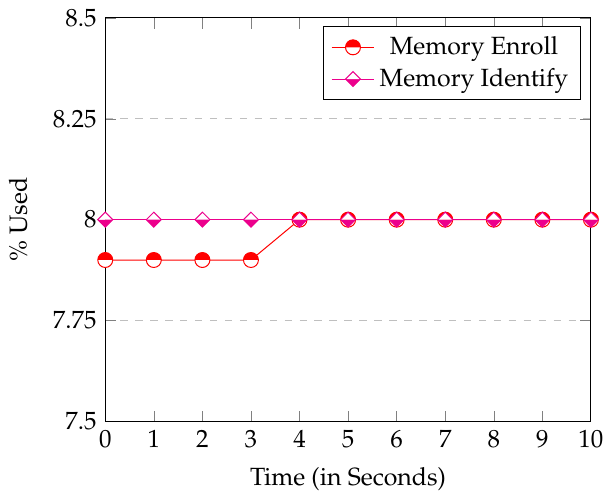
Figure 8. Memory Usage by the Enroll and Identify